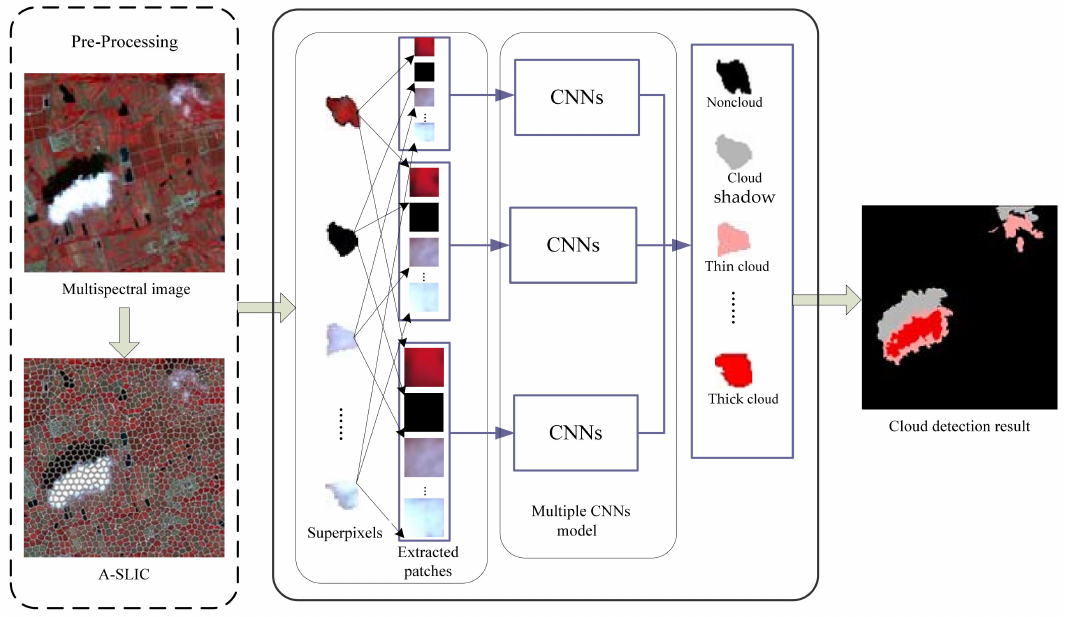
Figure 1. Proposed cloud detection framework. A-SLIC: adaptive simple linear iterative clustering; MCNNs: multiple convolutional neural